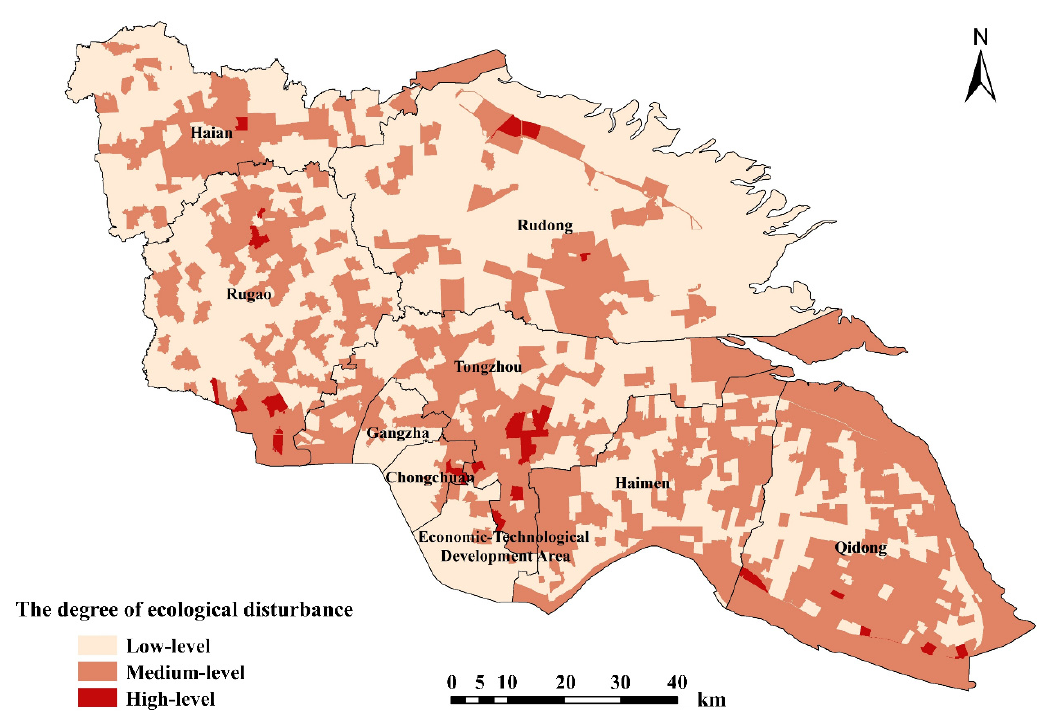
Figure 7. Degree of ecological disturbance caused by RSEEL at the village level.